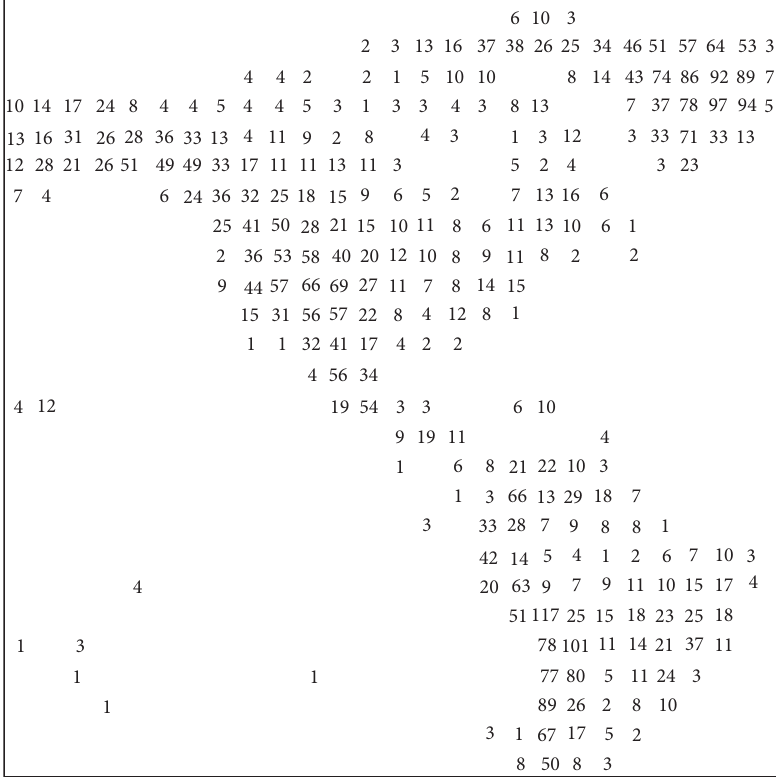
Figure 1: Section of a table showing the hand-digitized orography of Western Hemisphere at a resolution of five degrees latitude and longitude from [8].